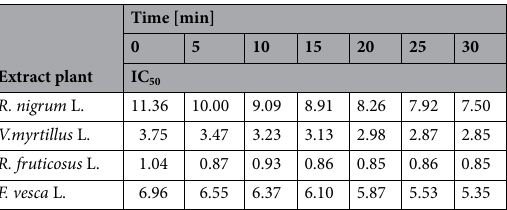
Table 2. Values of IC 50 for leaf extracts of R. nigrum L., V. myrtillus L., R. fruticosus L. and F. vesca L . after different time of exposure.